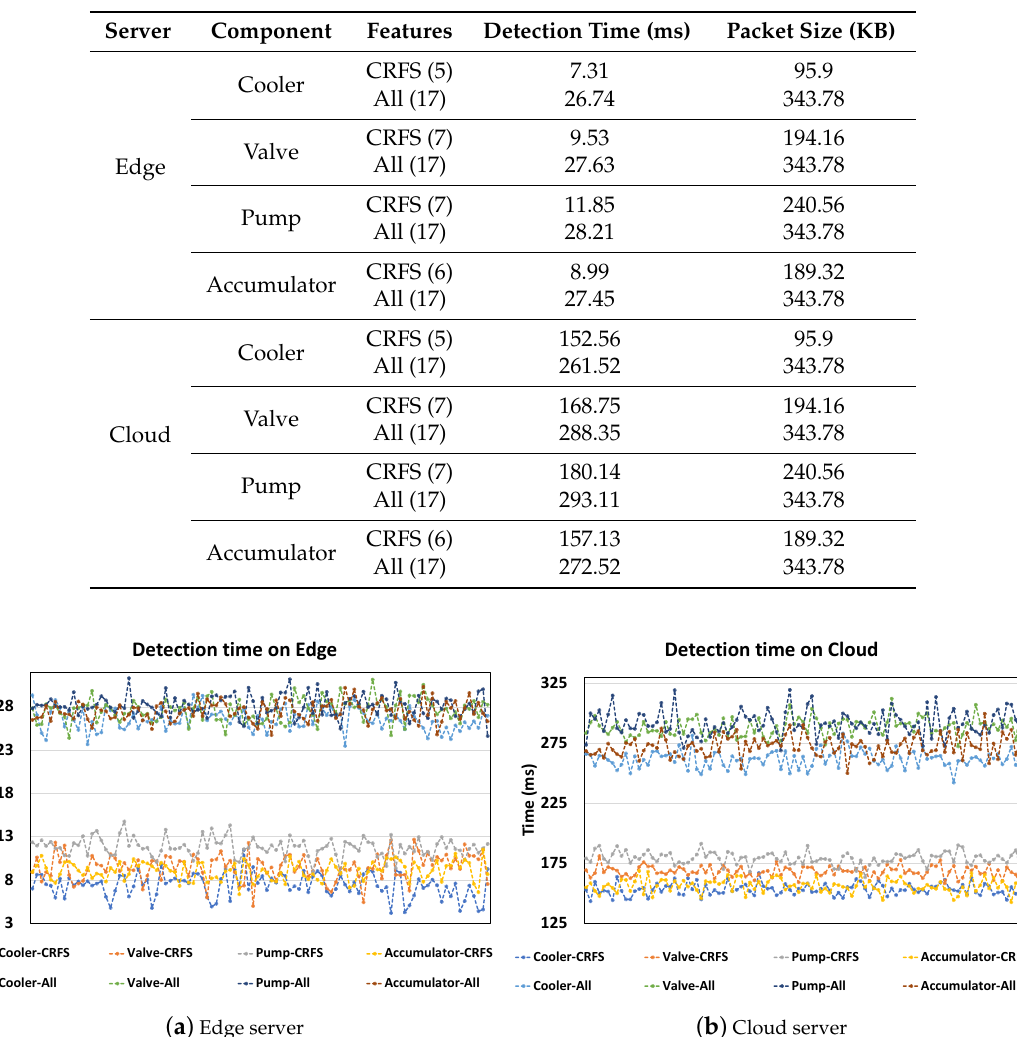
Table 6. Performance of server types.